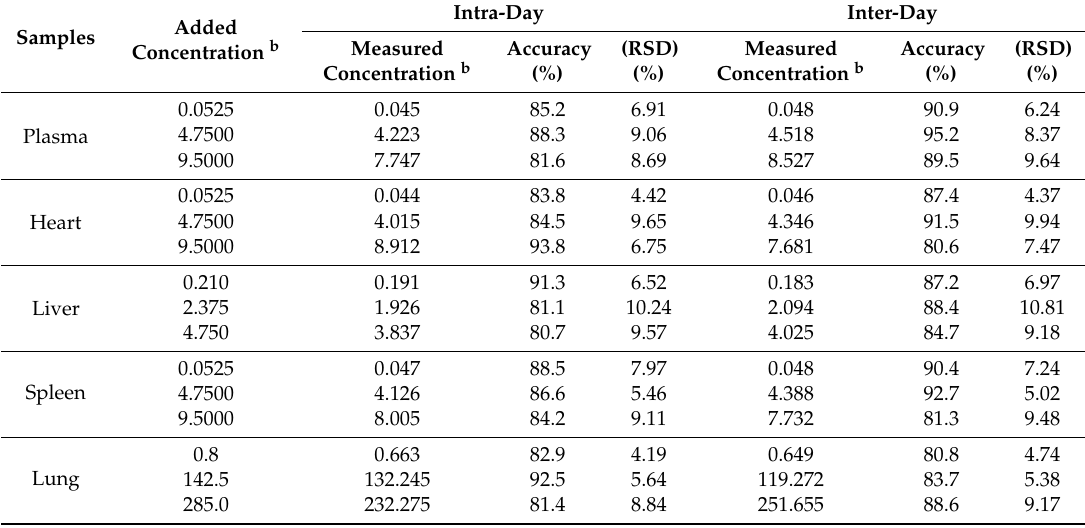
Table 2. Intra- and inter-day accuracy and precision data for baicalin in rabbit plasma and tissues a